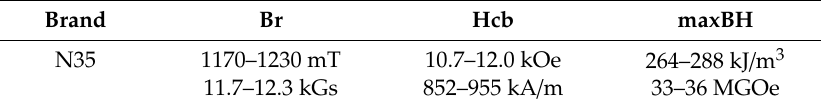
Figure 13. Prototype of the designed sensor: ( a ) Photographic view of the sensor; ( b ) Printed circuit board. Table 2. Properties of the NdFeB35 permanent magnet.